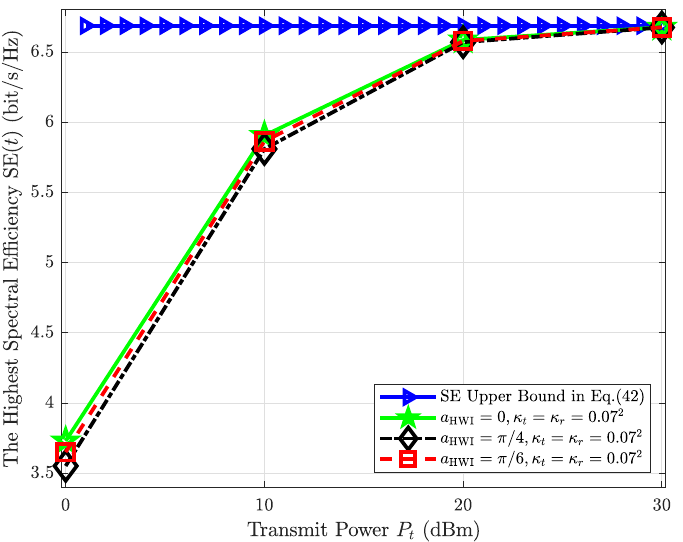
Figure 9. The highest spectral efficiency for one vehicle pass with different transmit power P t . K = 4, M × N = 128 2 , and P t = 0,10,20,30 dBm. Note that the upper bound for SE is based on